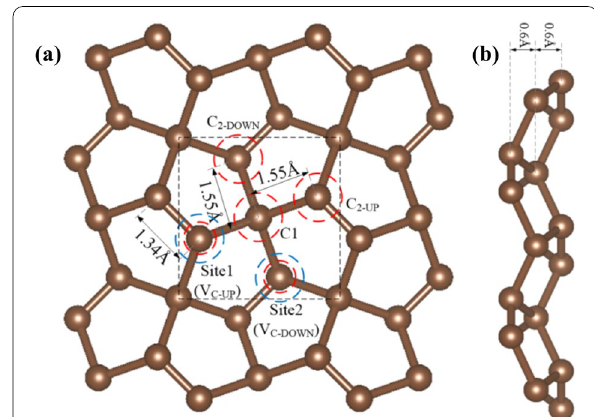
Table 1 Calculated Δ G